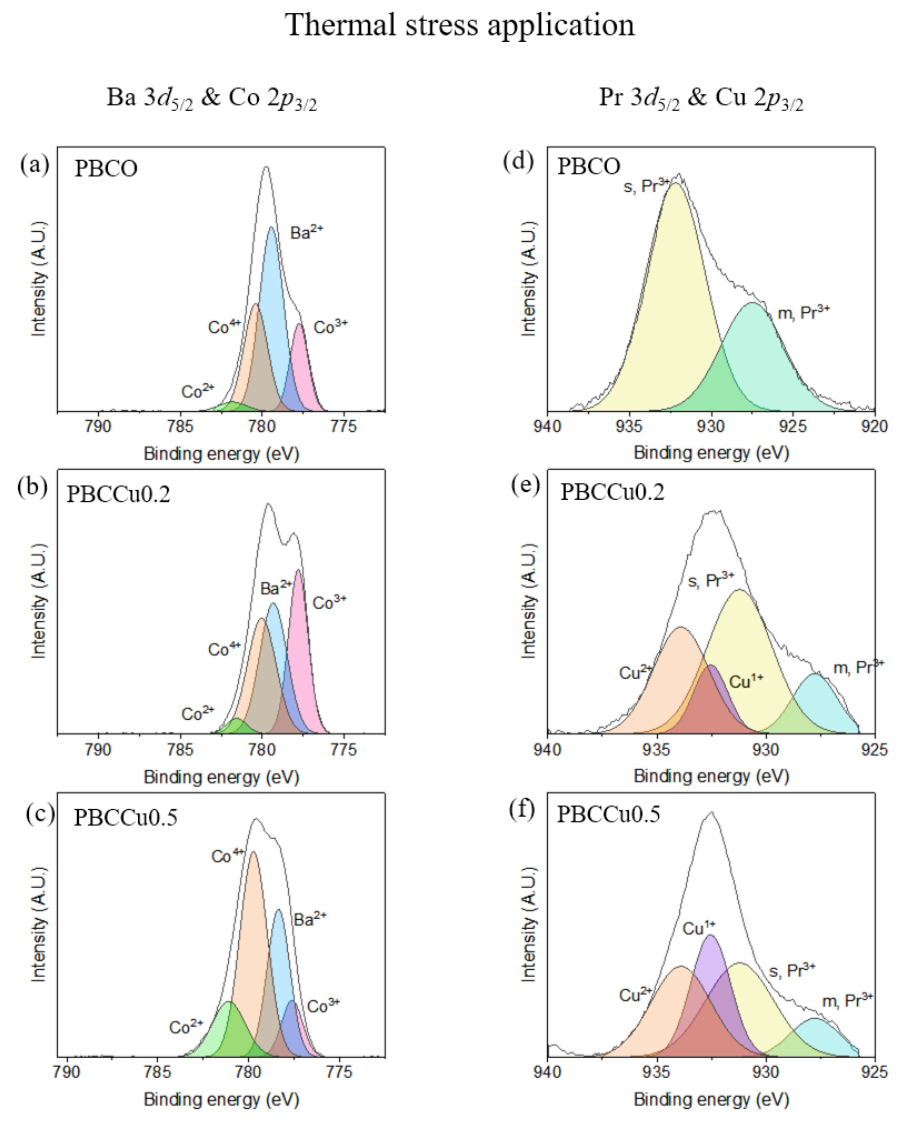
Figure 3. Core-level spectra (black solid line) together with the fit results (colored area) for PBCCu x after applying thermal stress for 100 h on 1050°C, Ba 3d 5/2 and Co 2p 3/2 : ( a ) PBCO; ( b ) PBCCu0.2; ( c ) PBCCu0.5, Pr 3d 5/2 and Cu 2p 3/2 ; ( d ) PBCO; ( e ) PBCCu0.2; ( f ) PBCCu0.5. Table 1. Ionic ratio of B-site metal ions and average oxidation state for pristine and thermally degraded specimens.